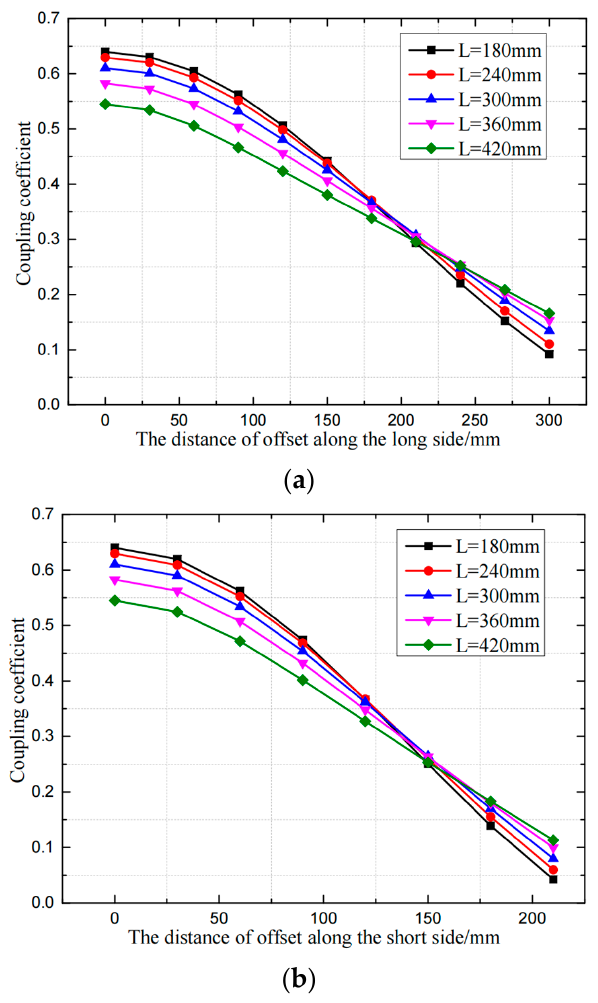
Figure 9. Comparison of anti-migration capabilities of different coil hole sizes: ( a ) offset along the long edge, ( b ) offset along the short edge.